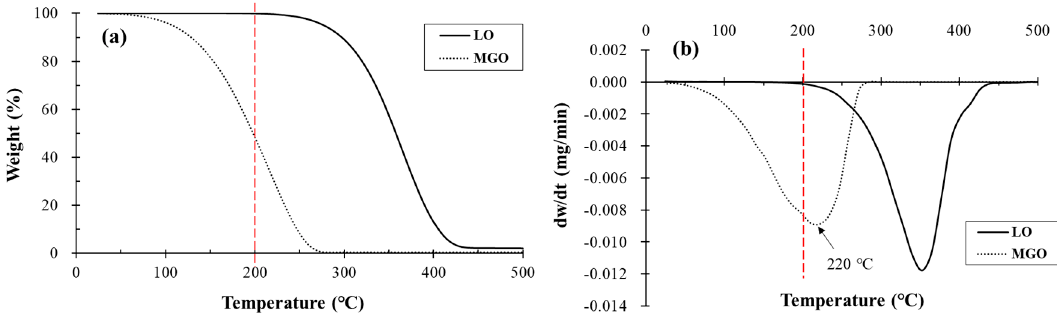
Figure 3. ( a ) Thermogravimetric analysis (TGA) and ( b ) derivative thermogravimetric (DTG) curves of lubricating oil (LO) and marine gas oil (MGO); LO starts to degrade at the temperature indicated with a red dashed line.